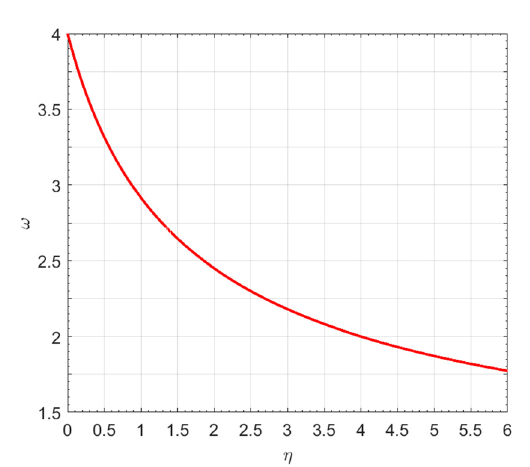
ε ε and 2 . Figure 4. The variation of ω with changing ε 1 and ε 2 .